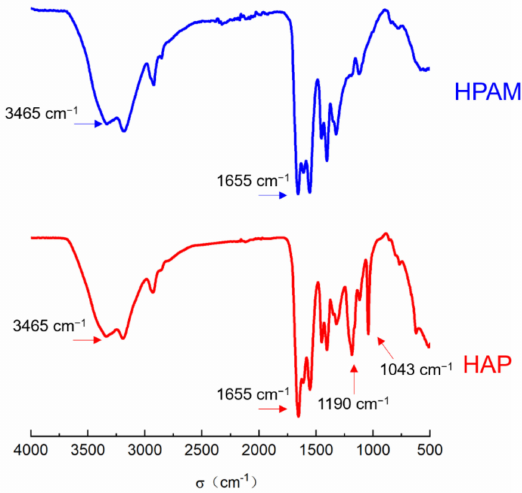
Figure 2. The comparison between FTIR spectra of HAP and HPAM.